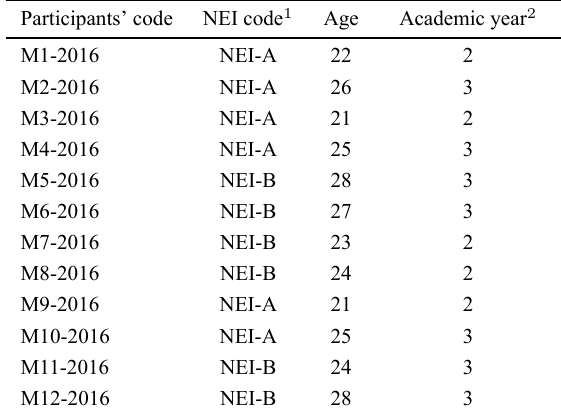
Table 1. Summary of participants’ characteristics.